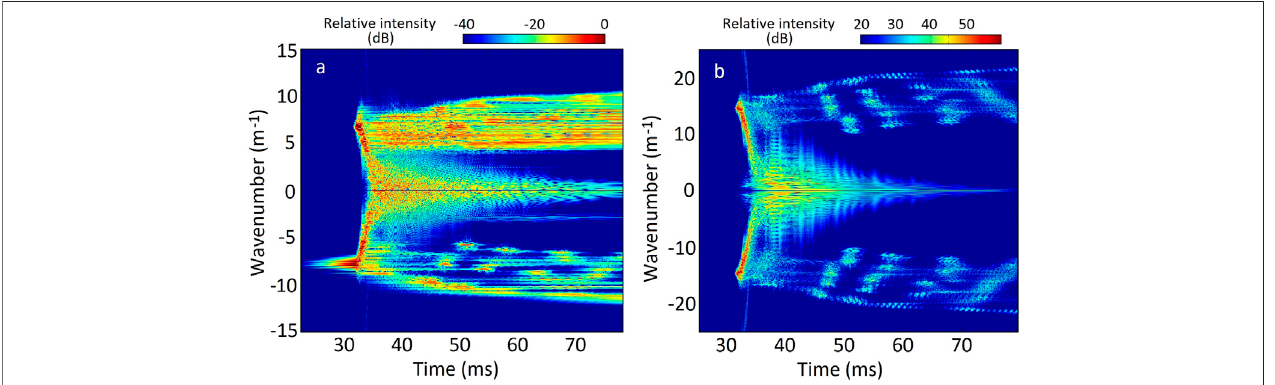
FIGURE 2 | Adapted from Akbari et al. (2016): Results from a one-dimensional simulation of Langmuir turbulence induced in the nightside F region auroral plasma with a 125 eV electron beam. The left and right panels show the evolution of the electric fi eld and ion density perturbations, respectively, as a function of time and wavenumber. A cascade of parametric decay instabilities is seen after t ∼ 32 ms following an exponential ampli fi cation of beam-resonant Langmuir waves at k ∼ 8m − 1 . Other parameters of the electron beam are n b / n 0 (cid:1) 6 × 10 − 6 and Δ v b / v b (cid:1) 0 . 3.